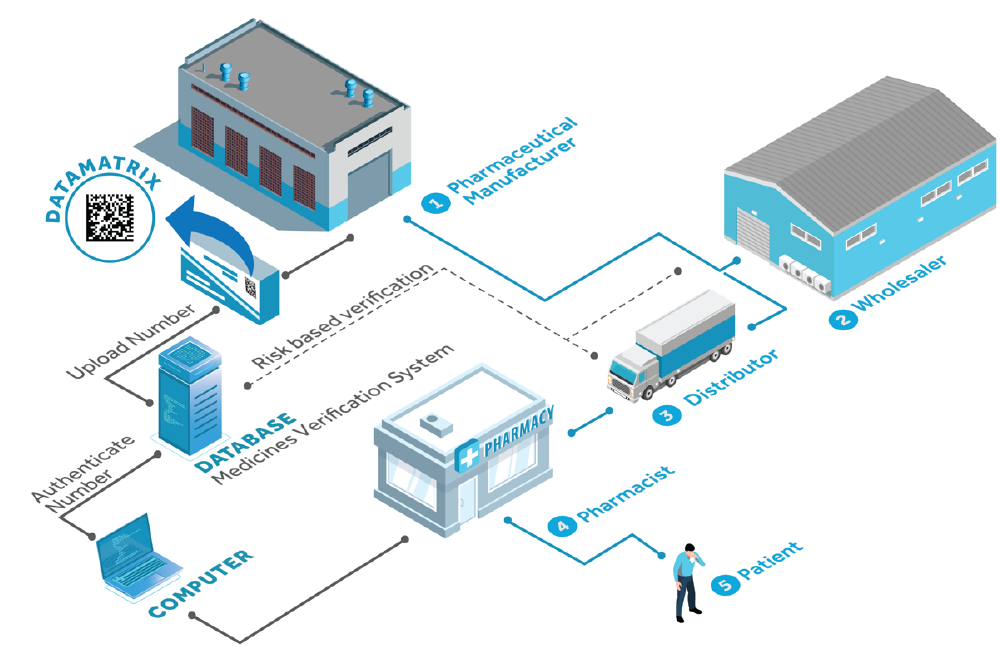
Figure 1. Product flow schematic. Adapted from